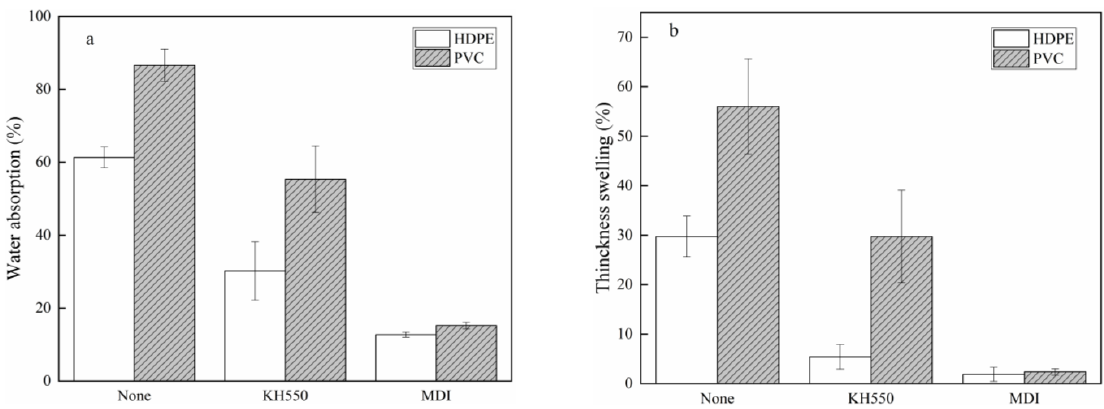
Figure 7. ( a ) Water absorption and ( b ) thickness swelling of